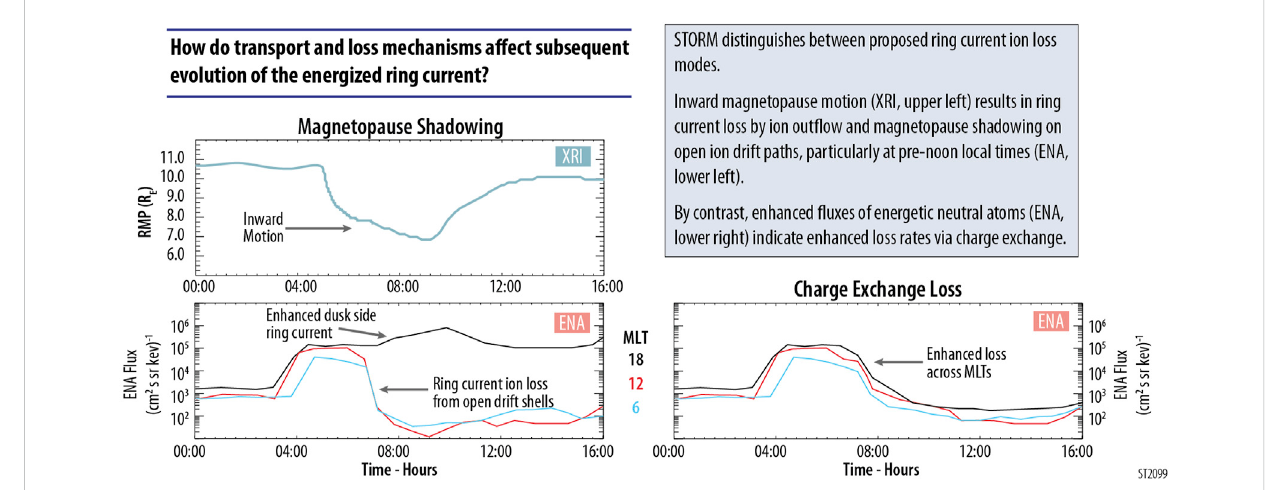
FIGURE 6 Working in tandem, STORM XRI and ENA resolve competing theories for ring current loss via charge exchange or magnetopause shadowing.